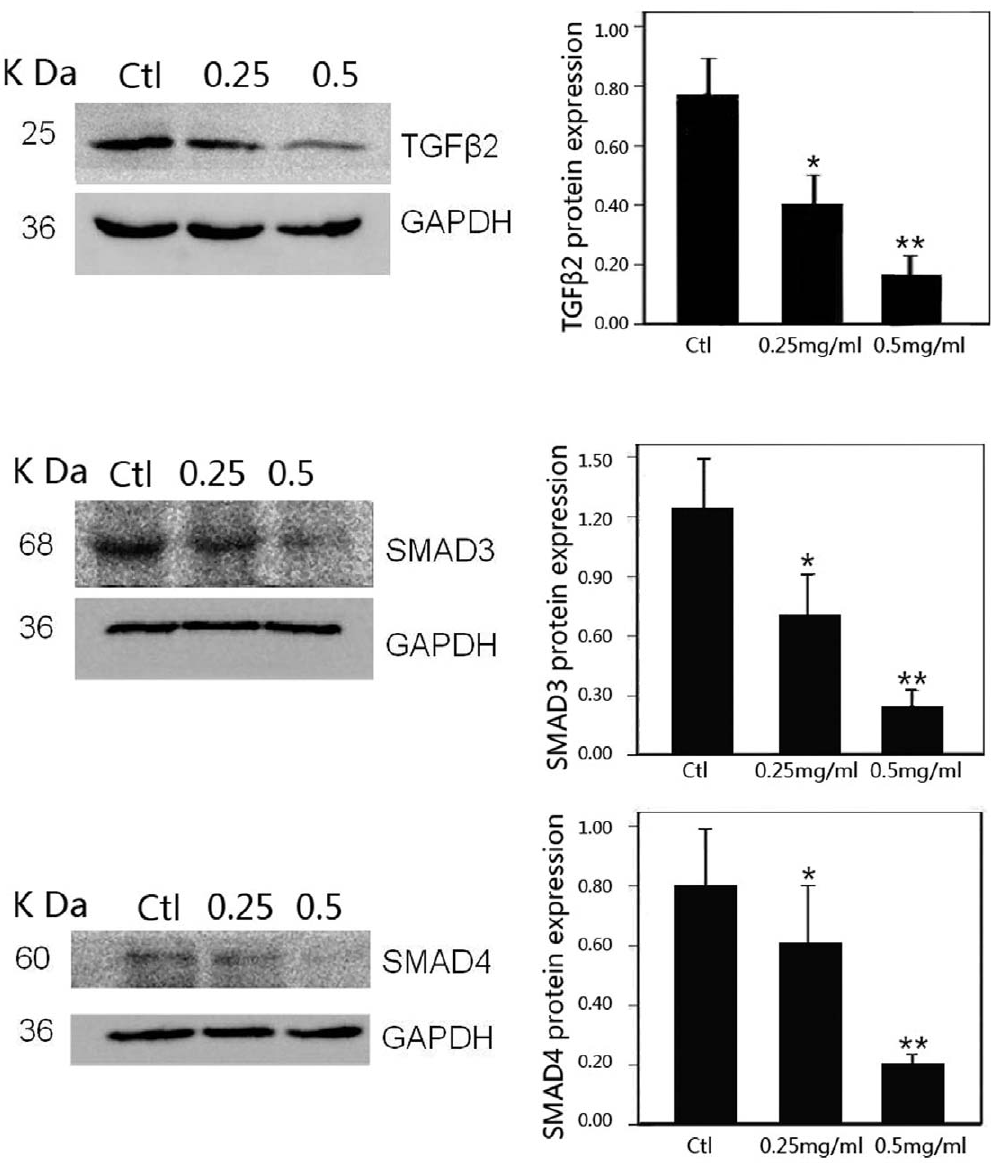
Figure 8. Inhibitory effect of pirfenidone on expression of TGF b 2 and SMADs protein in SRA01/04 cells. Western blot showed that pirfenidone reduced the protein levels of TGF b 2, SMAD3 and SMAD4 when compared with control cells. *P , 0.05 and **P , 0.01 versus the corresponding value for control cells. Data are mean 6 SD of results from three independent cultures.